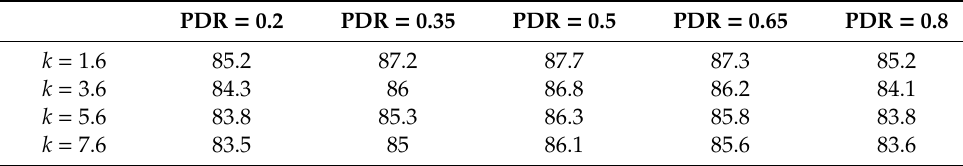
Table 4. Overview of parameter designs and their e ffi